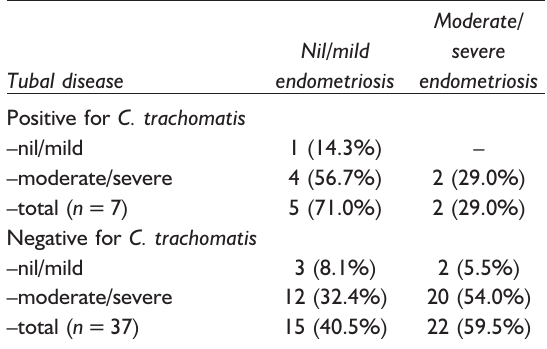
Table 2 C. trachomatis pathology in different categories of endometriosis and intraluminal disease: numbers (%) of